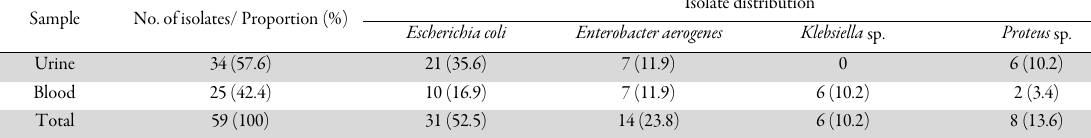
Table 3. Summary of isolates obtained from the three study sites Sample